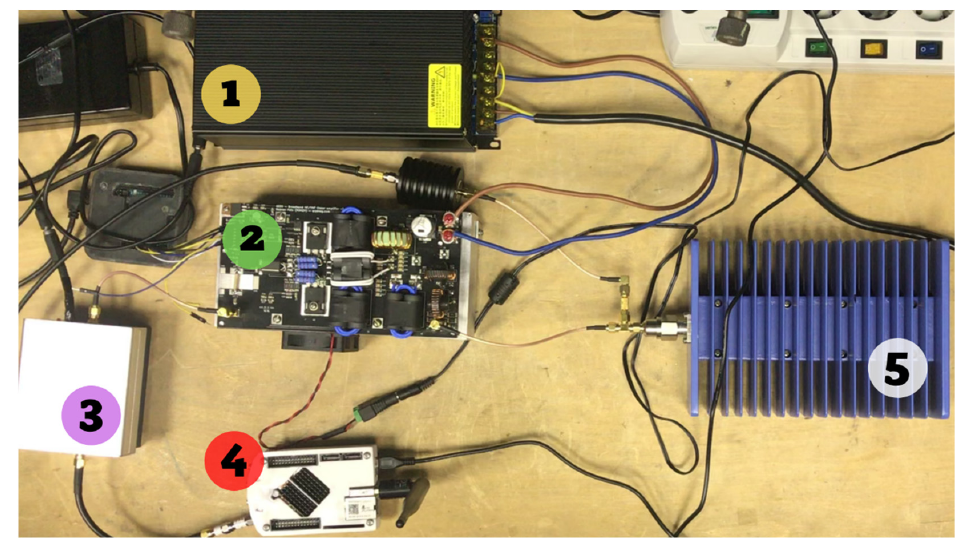
Figure 2. The photo of the assembled model of the transmitting part of the ionosonde without a housing. The numbers indicate 1—amplifier power supply, 2—linear amplifier A600, 3—5 W preamplifier, 4—SDRlab 122-16 in a 3d-printed case as a master oscillator, 5—matched load.